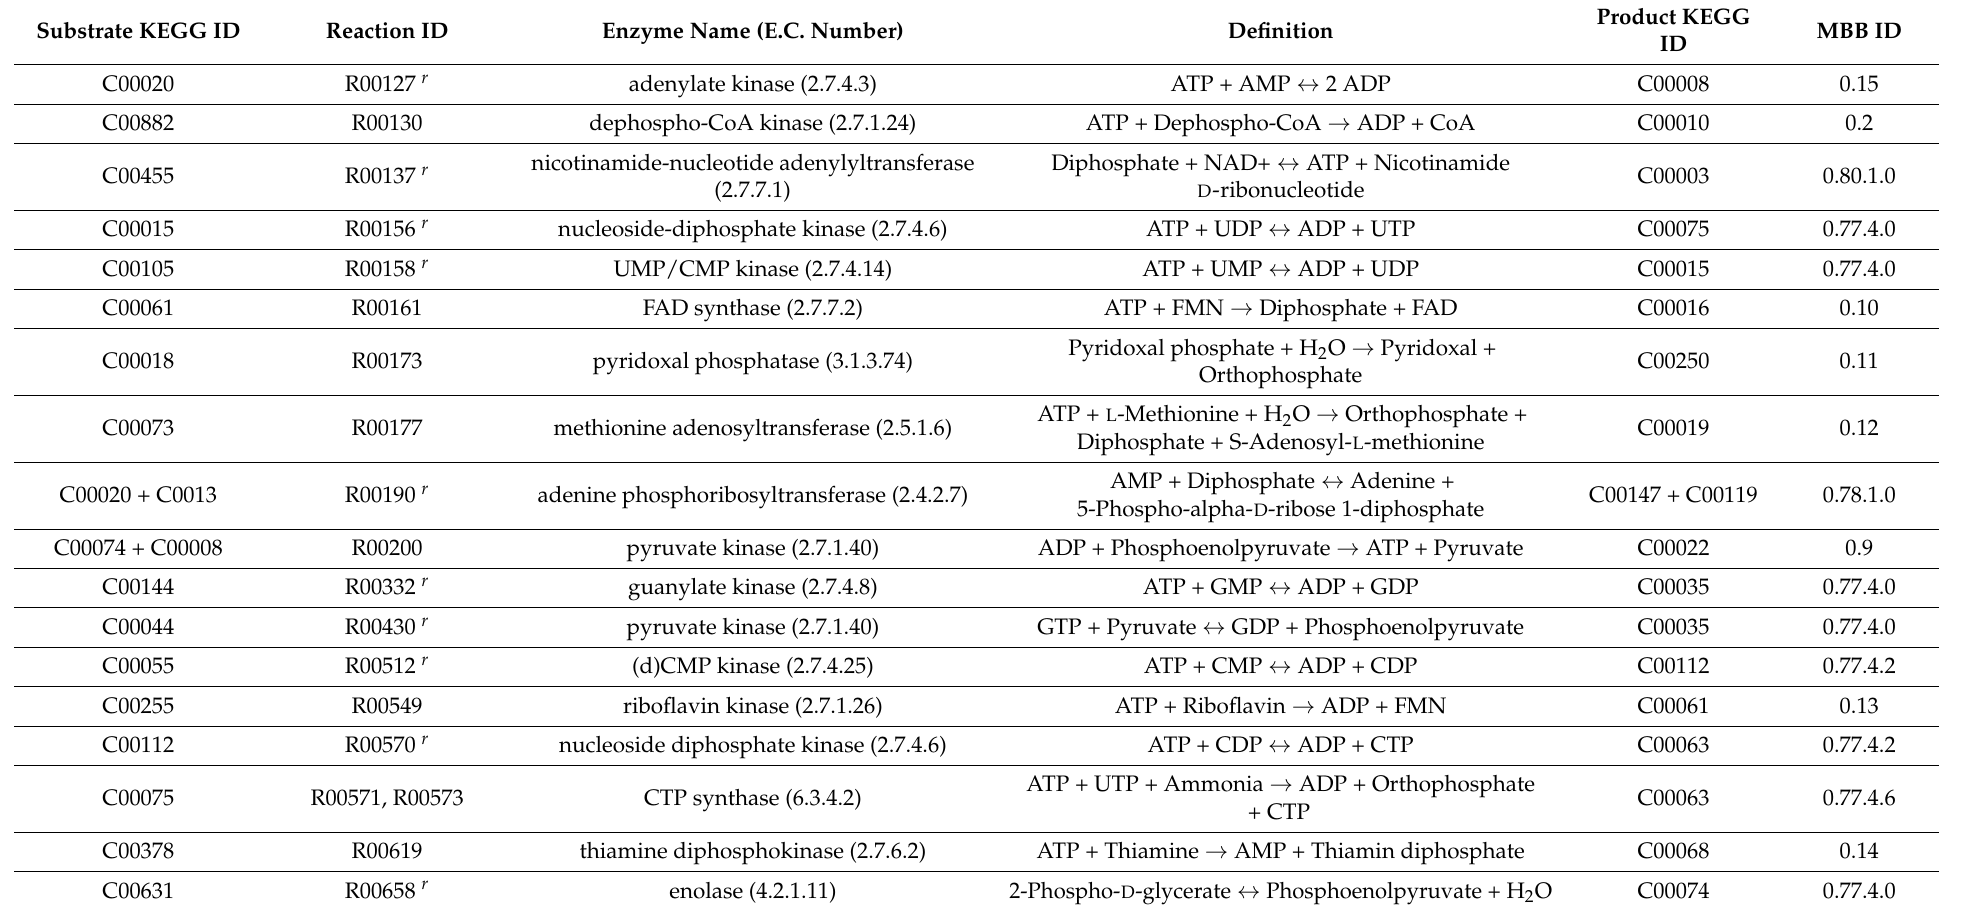
Table 1. Reactions, enzymes, and compounds of the minimal metabolic network presented in Figure 2. Reversible reactions are denoted by the superscript r . MBB IDs are the identification numbers of the metabolic building blocks to which each reaction is contracted into, according to the MetaDAG analysis (Figure